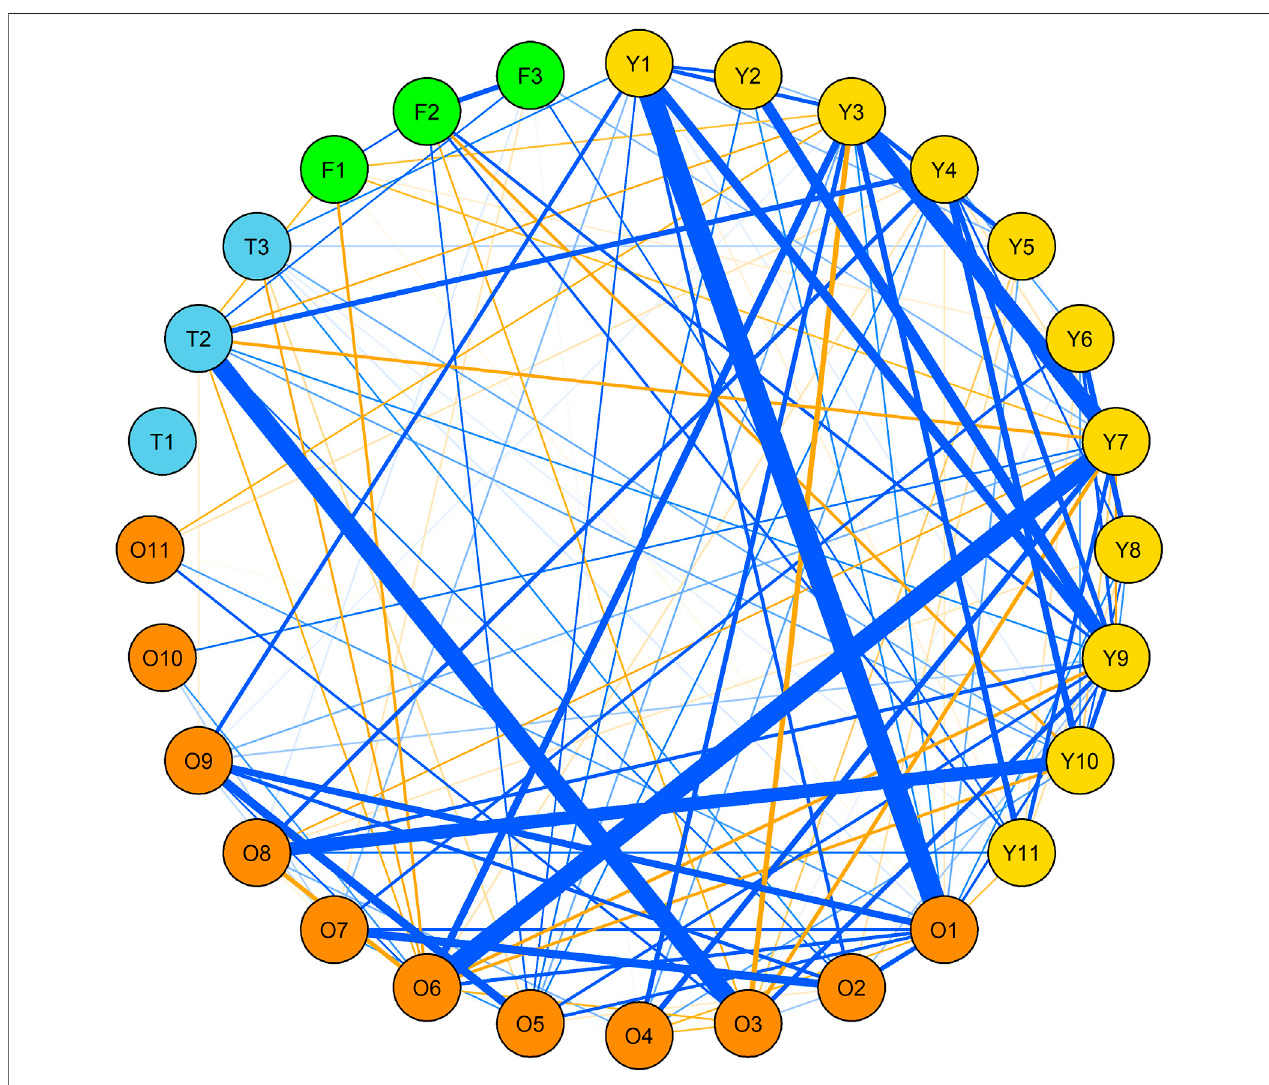
FIGURE 2 | Correlation network among yellow wheat blossom midge (yellow), orange wheat blossom midge (orange), thrip (skyblue) and frit fl y (green) in spring wheat (SW) panel. Only correlations > 0.1 R2 and signi fi cant at at least 0.05 p -values are shown. Blue and orange lines indicate positive and negative correlations, respectively where the thickness of the line is proportional to the strength of the correlation. For details, see Supplementary Table S2 .